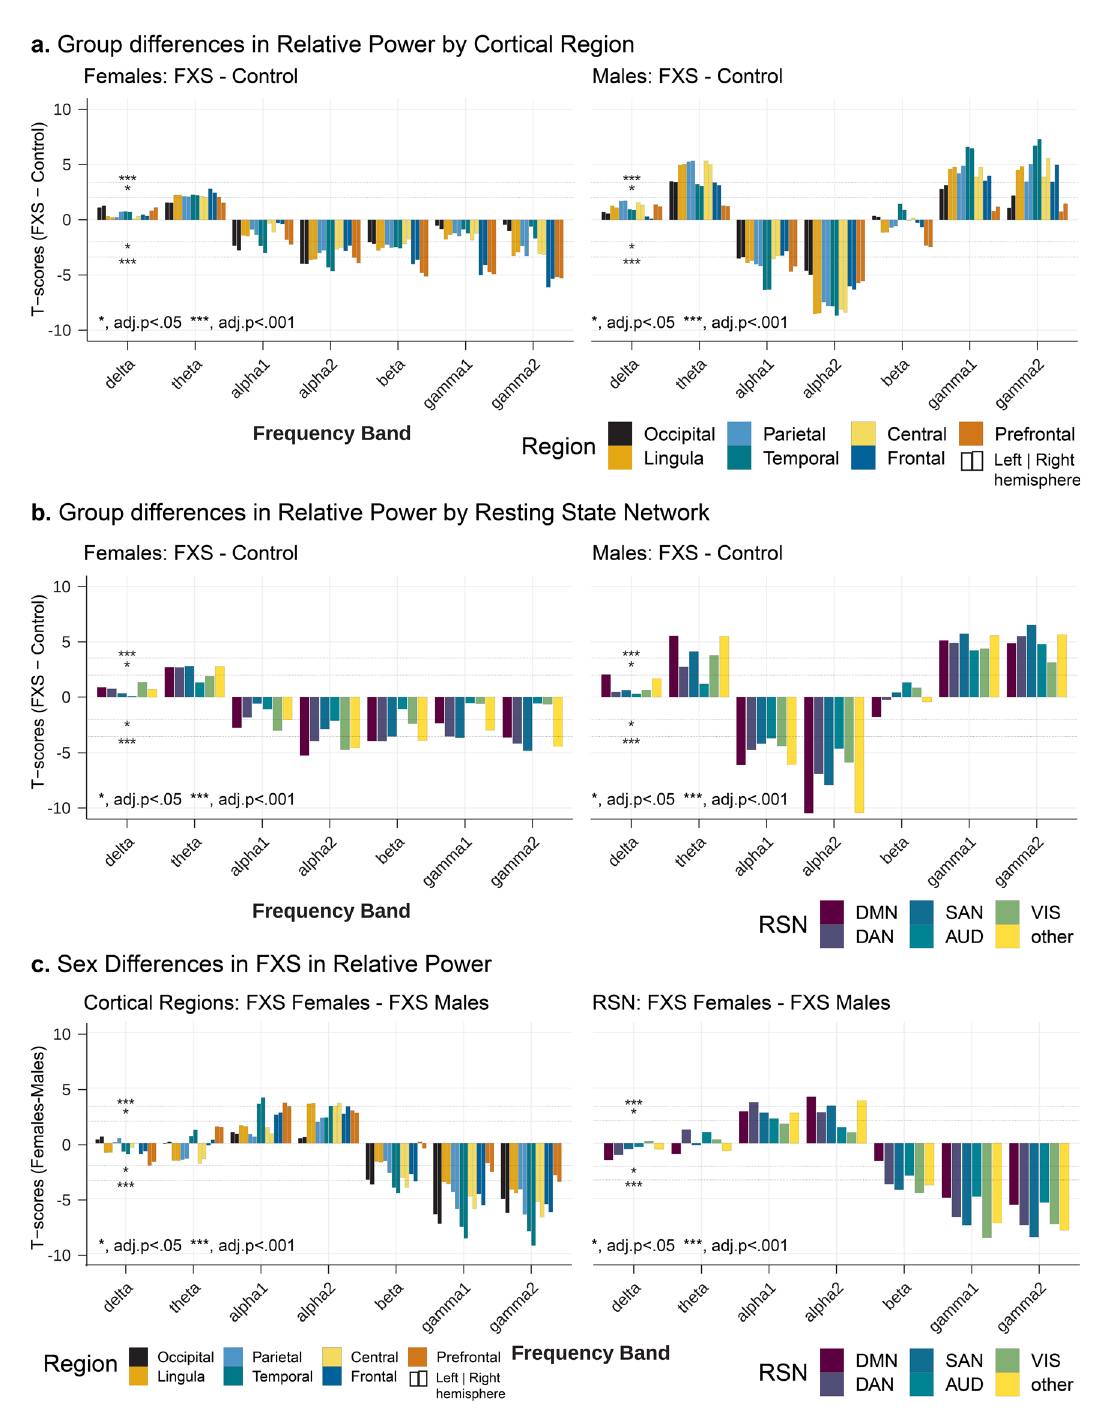
Fig. 3 Relative power differences by cortical region or resting-state network. Bar plots represent 5% FDR corrected pairwise contrasts of model estimates of log relative power between FXS ( n = 70) and control ( n = 71) participants. For region plots, left and right of individual bars correspond to the right and left hemispheres, respectively. Positive t -values indicate that log relative power estimates in FXS are greater than those in control. a Sex-matched group differences in log relative power by cortical region. Males with FXS demonstrate region-speci fi c increases in gamma power compared to controls with sparing of prefrontal regions. b Sex-matched group differences in log relative power across RSNs. A signi fi cant increase in theta and gamma power, as well as a decrease in alpha power, were observed across cognitive and sensory RSNs of males with FXS. Compared to control females, females with FXS had only modest changes in RSNs including similar gamma levels in visual and auditory networks. Obligate mosaicism in Fmr1 in females with full mutation FXS may attenuate EEG alterations. c We explored sex differences in relative power within the FXS group by region and RSN. Positive t -values indicate that log relative power estimates in males with FXS are greater than in females with FXS. There were fewer differences between males and females with FXS than in control comparisons, except for decreased alpha and that gamma activity remained elevated in most regions and all RSNs in males. Resting-state network abbreviations: DMN default mode network, DAN dorsal attention network, SAN salient affective network, VIS visual attention network, AUD auditory